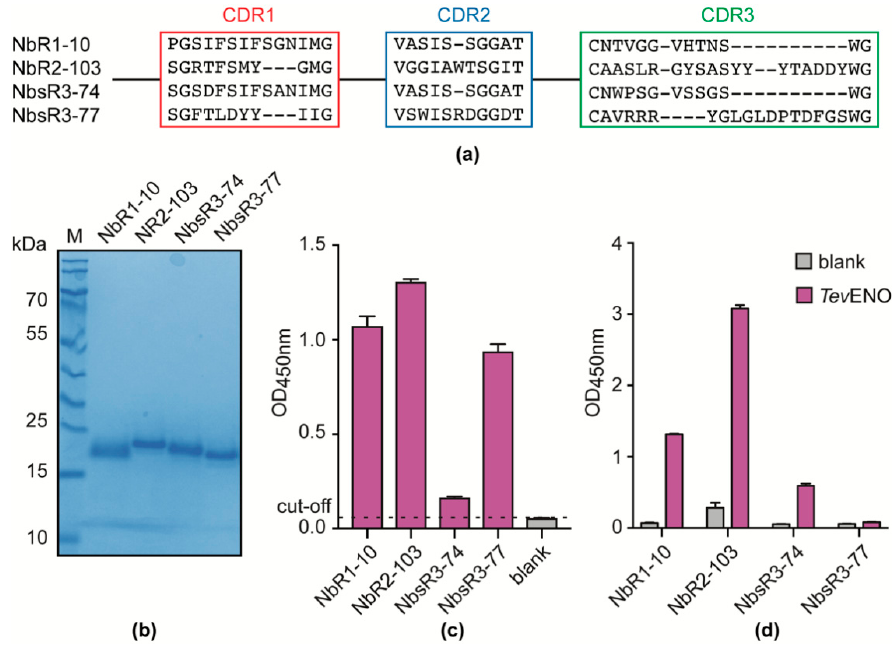
Figure 5. Identification of additional anti- Tev ENO Nbs. ( a ) Sequence alignment corresponding to CDR1, 2, and 3 regions of the anti -TevENO Nbs. ( b ) SDS-PAGE analysis of retrieved Nbs after purification. Lane M , PageRuler Prestained Protein Ladder. ( c ) Indirect ELISA performed on recombinant Tev ENO with the retrieved Nbs. The black dashed line refers to the ELISA cut-o ff . ( d ) Heterologous sandwich ELISA with His-tagged Nb11 and HA-tagged variants of the newly identified Tev ENO binders as capturing and detecting agents, respectively. The grey column indicates the negative control (without Tev ENO), whereas the purple column indicates the experimental sandwich system. All ELISAs were performed in triplicate (error bars are